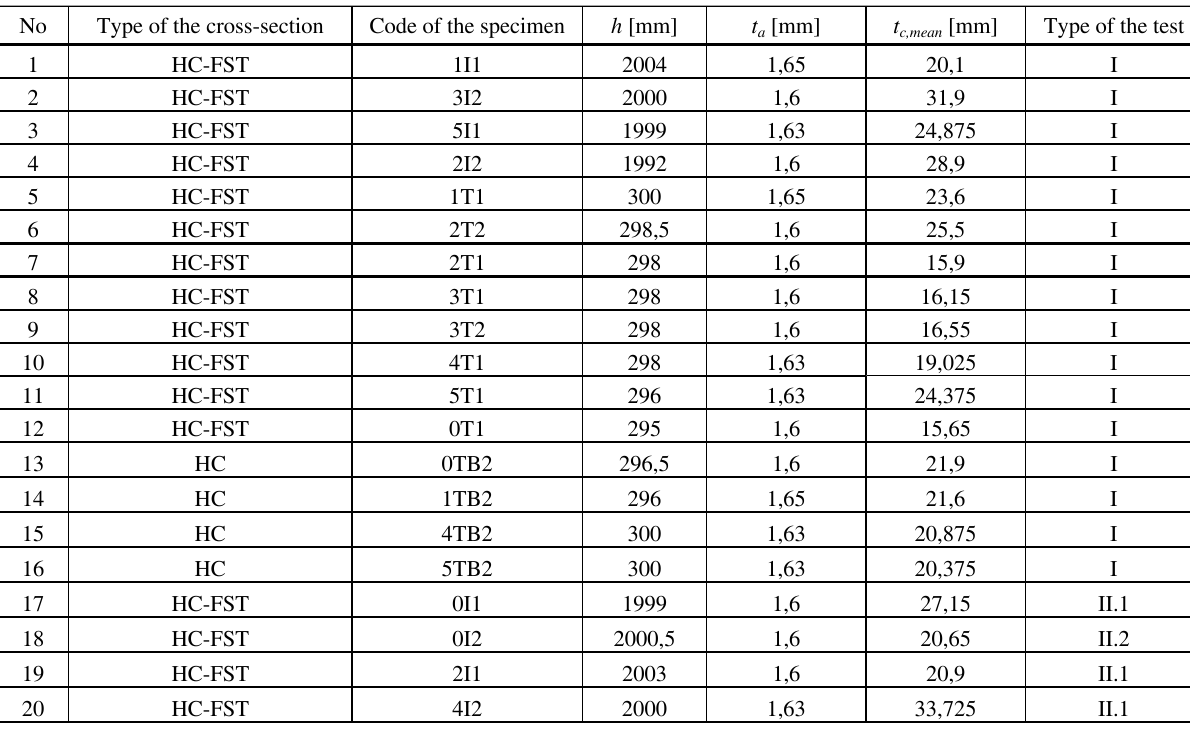
Table 1 . Geometrical parameters of HC-FST and HC specimens No Type of the